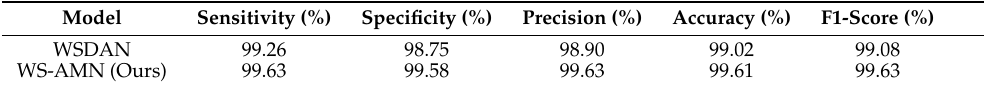
Table 5. Comparison of WSDAN and WS-AMN.